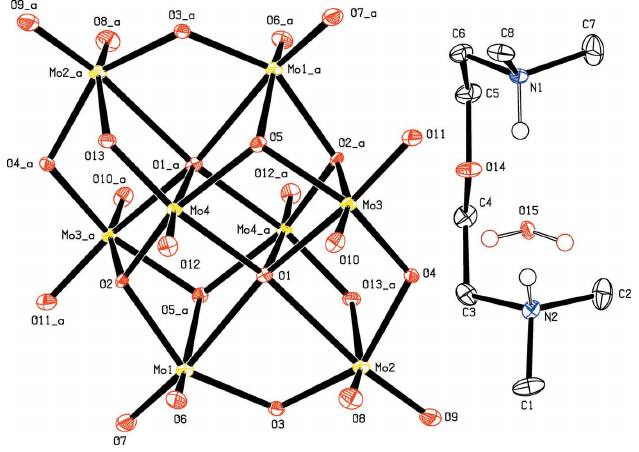
Figure 1 The molecular entities in the title compound with ellipsoids drawn at the 50% probability level. Only the symmetry-unique cation and solvent water molecules are shown. H atoms bonded to C atoms are omitted for the sake of clarity. Atoms labeled with the suffix ‘a’ are related by the symmetry operator ( (cid:3) x + 1, (cid:3) y + 1, (cid:3) z + 1).